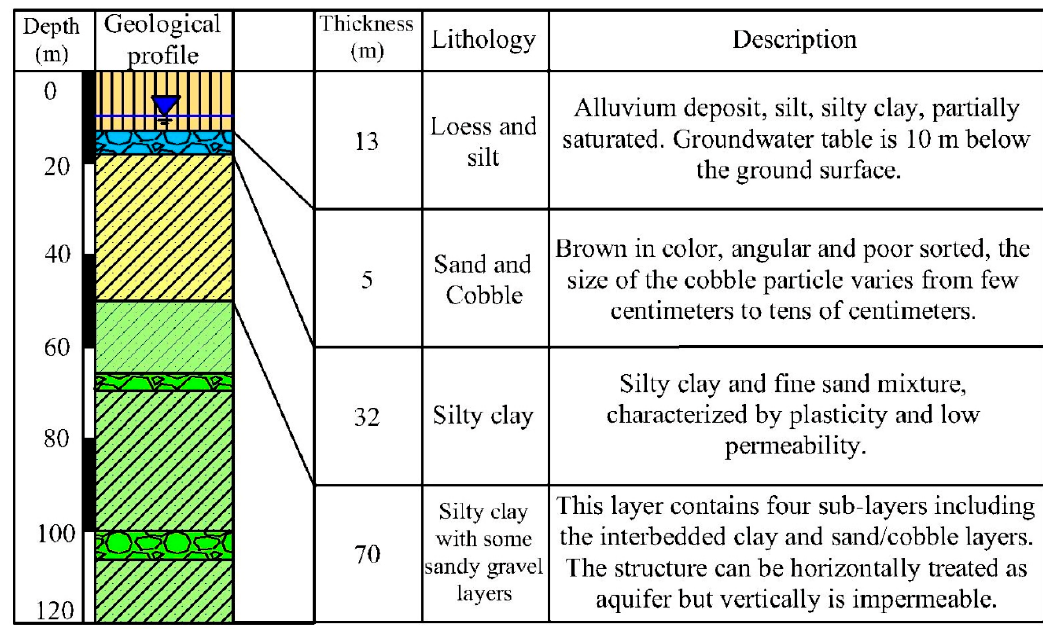
Figure 2. A geological profile displays the sedimentary sequence of rock formations on the testing